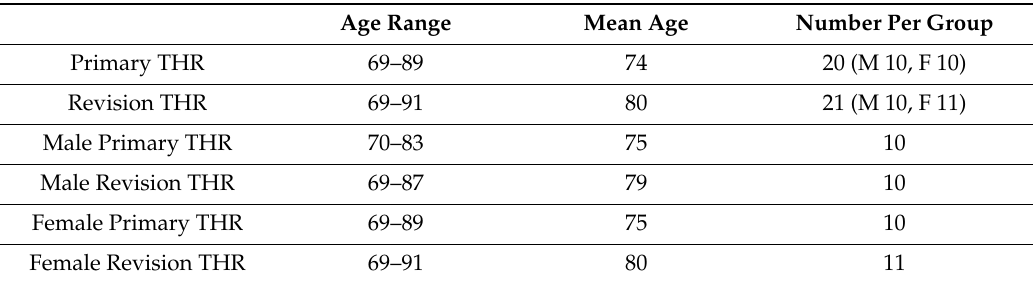
Table 1. Patient demographics for primary and revision cohorts. THR: Total hip replacement.